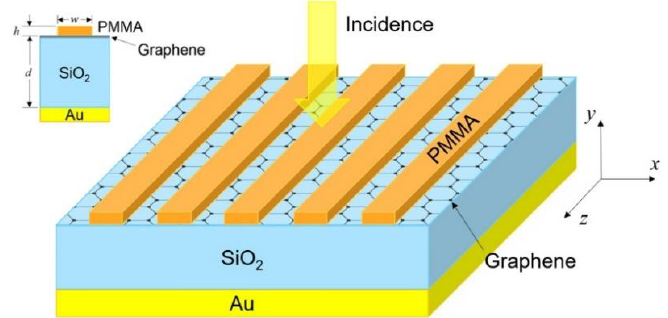
Figure 1. Schematic of the proposed graphene-based perfect absorber.